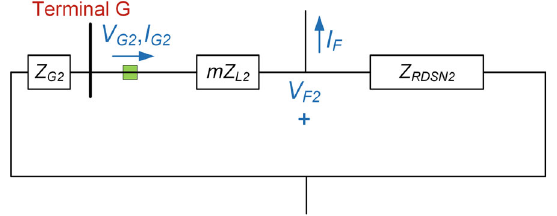
Fig. 8 Negative-sequence network of a general transmission line network during an unbalanced fault